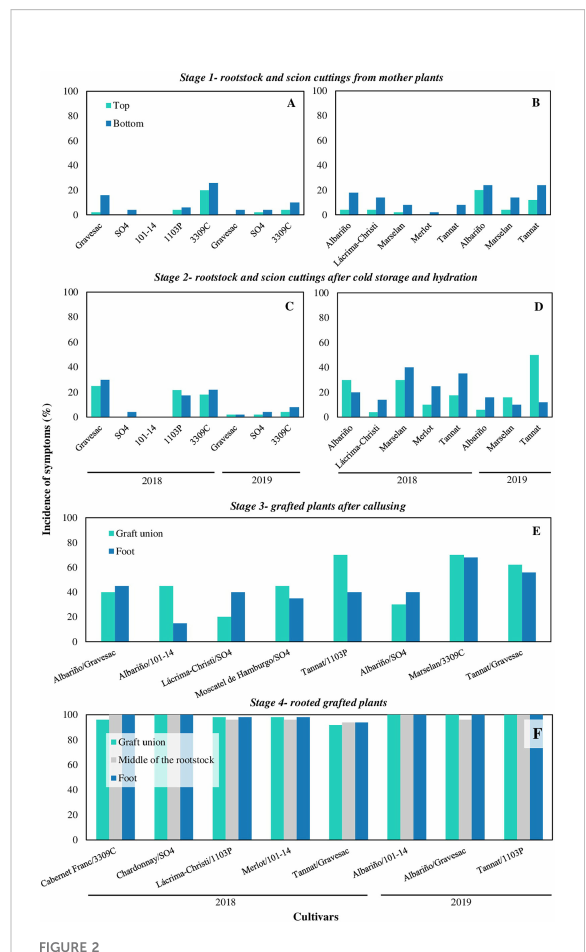
FIGURE 2 Incidence of grapevine trunk diseases symptoms in propagation materials of different cultivars, rootstocks, and combination cultivar-rootstocks throughout four stages of the nursery process in 2018 and 2019: (A) rootstocks and (B) scion cuttings from mother plants (stage 1); (C) rootstocks and (D) scion cuttings after cold storage and hydration (stage 2); (E) grafted plants after callusing (stage 3); (F) rooted grafted plants ready to plant (stage